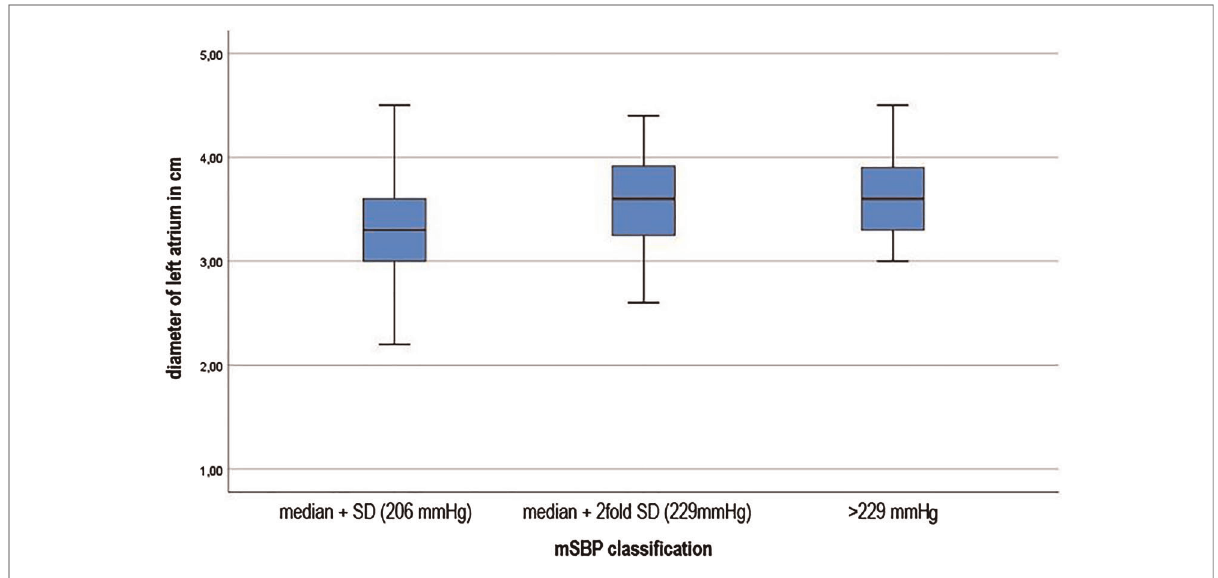
FIGURE 3 Left atrial dimension in dependence of increasing deviation from the mean (SBP).